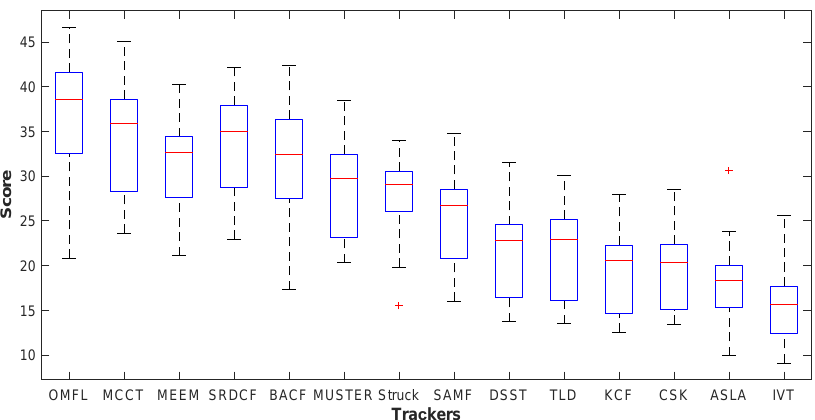
Figure 12. Analysis of area under curve (AUC)-based socres for all trackers with different attributes.